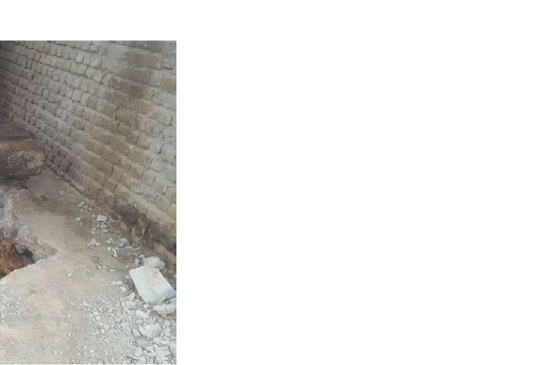
Figure 11. Comparison of vertical displacement of InSAR ascending and descending over time with GNSS station time series.